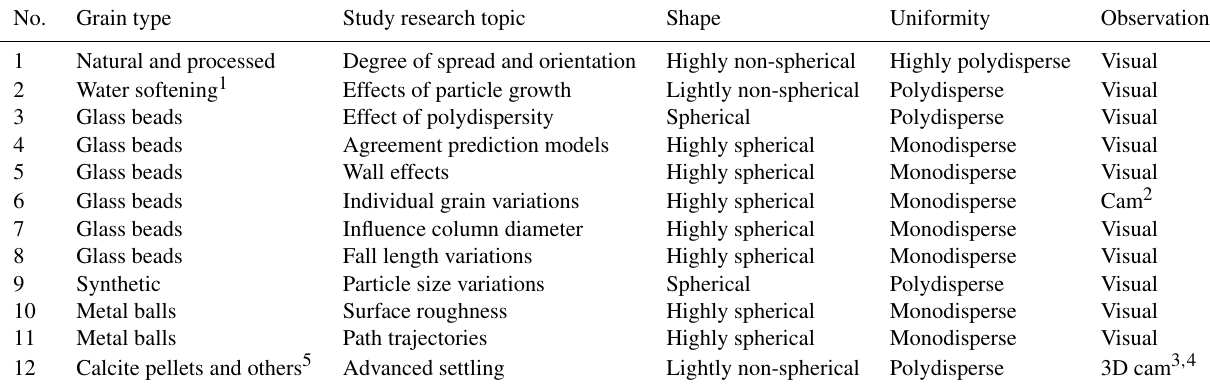
Table 2. Different types of terminal settling